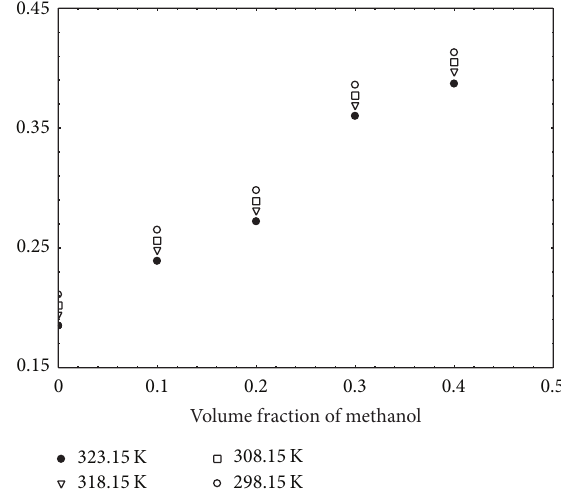
Figure7:Plotof (𝜂 𝑟 −1)/ √ 𝑐 versus √ 𝑐 forDTABsolutionat298.15 K.